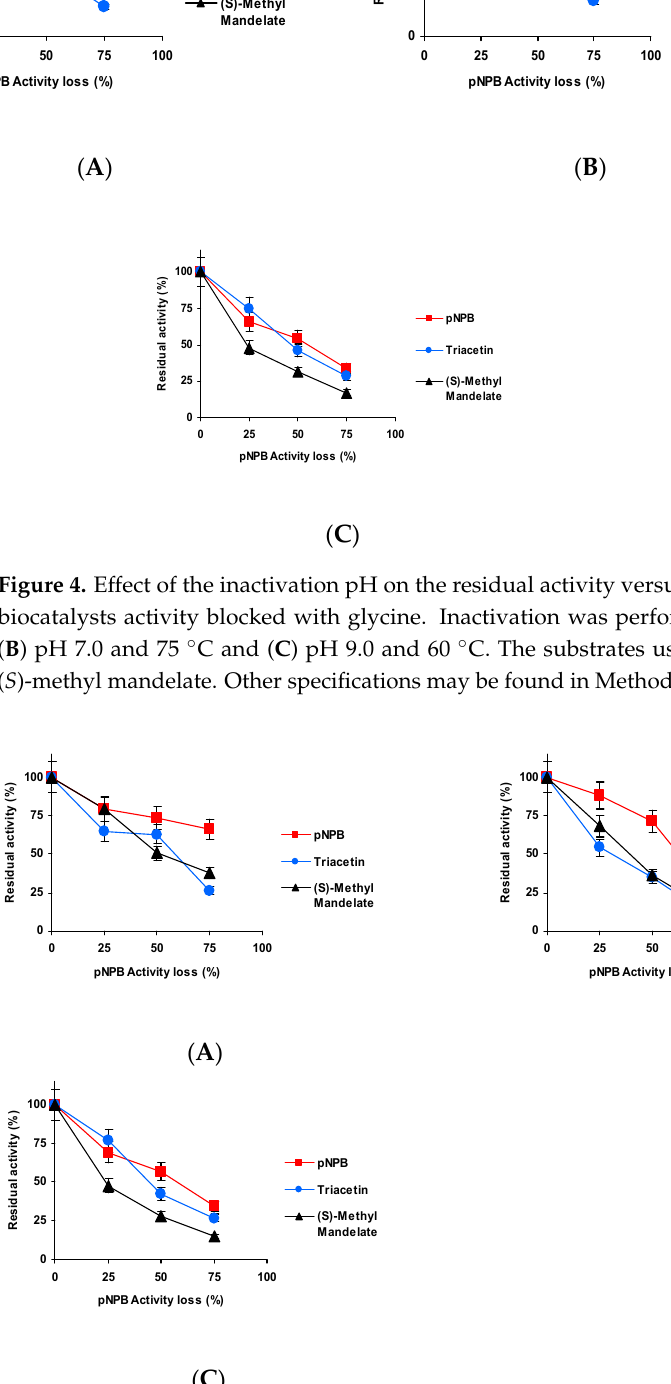
( B ) ( C ) Figure 6. Effect of the inactivation pH on the residual activity versus different substrates of CALB biocatalysts activity blocked with hexylamine. Inactivation was performed at ( A ) pH 5.0 and 80 °C, ( B ) pH 7.0 and 75 °C and ( C ) pH 9.0 and 60 °C. The substrates used were: p NPB; triacetin; and ( S )-methyl mandelate. Other specifications may be found in Methods section.